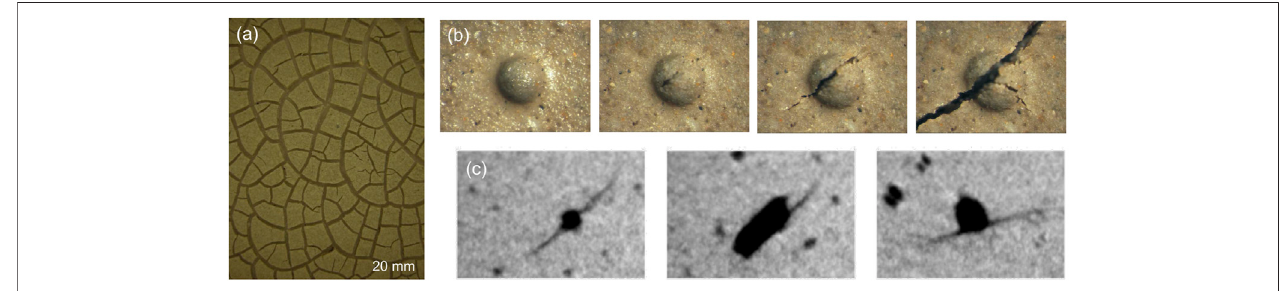
FIGURE10| Grain-displacivenon-wetting fl uidinvasion:desiccationcracks. (A) Surfacedesiccationcracks(ShinandSantamarina,2011b). (B) Crackinitiationata surface defect during drying (Shin and Santamarina, 2011a). (C) Internal desiccation cracks observed using X-ray micro CT (Zhao and Santamarina, 2020).